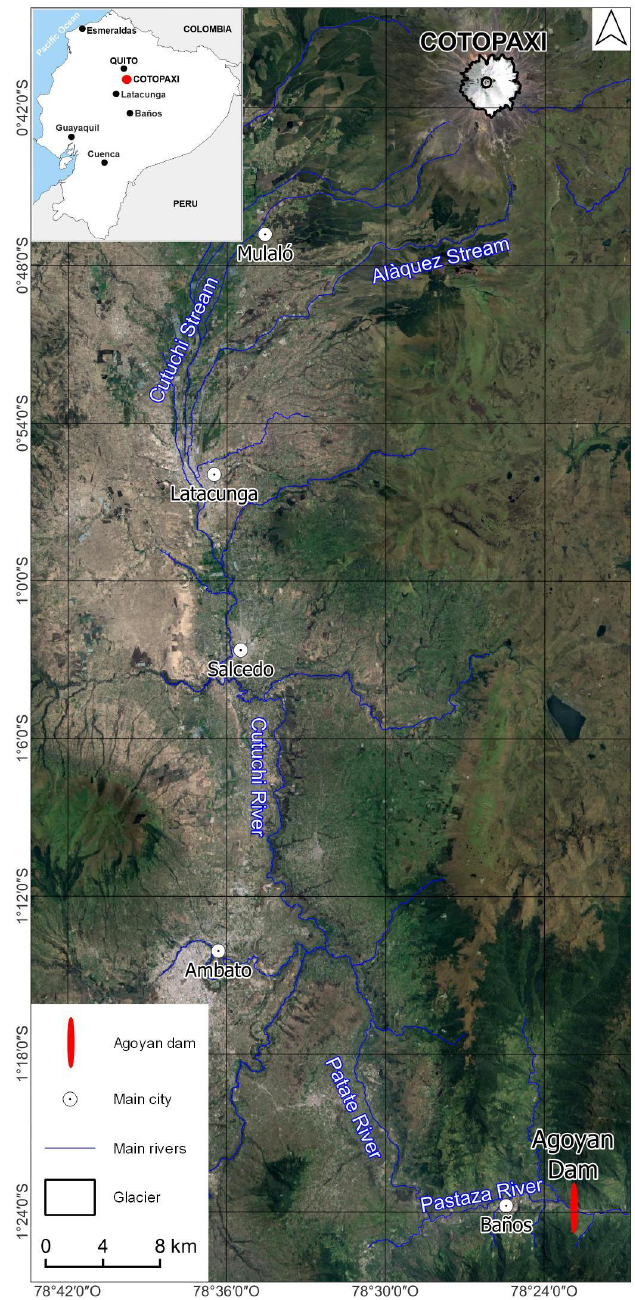
Figure 1. Google Earth image of the study area.